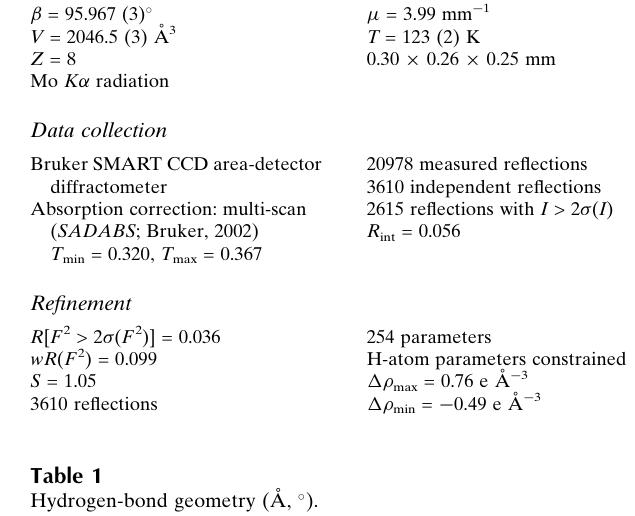
The title compound, C independent but essentially identical molecules in the asymmetric unit. Each molecule adopts a trans configuration with respect to the C N bond. In one of the molecules, the dihedral angle between the benzene ring and the hydrazine-